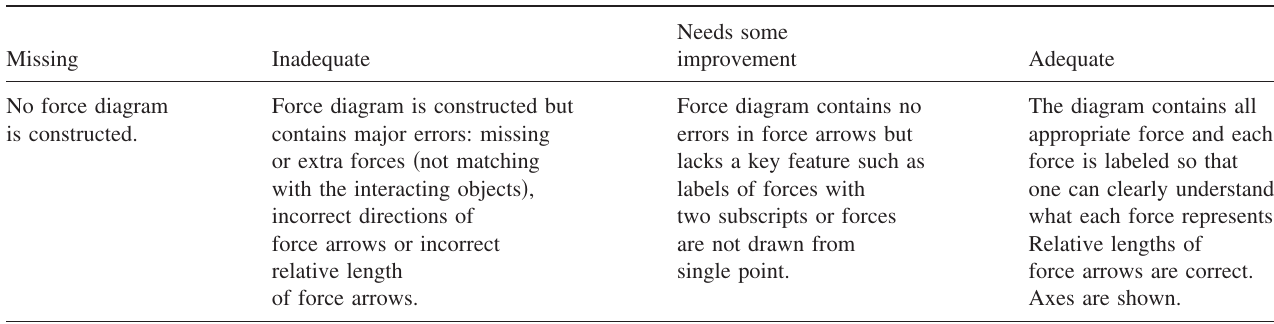
Missing Inadequate No force